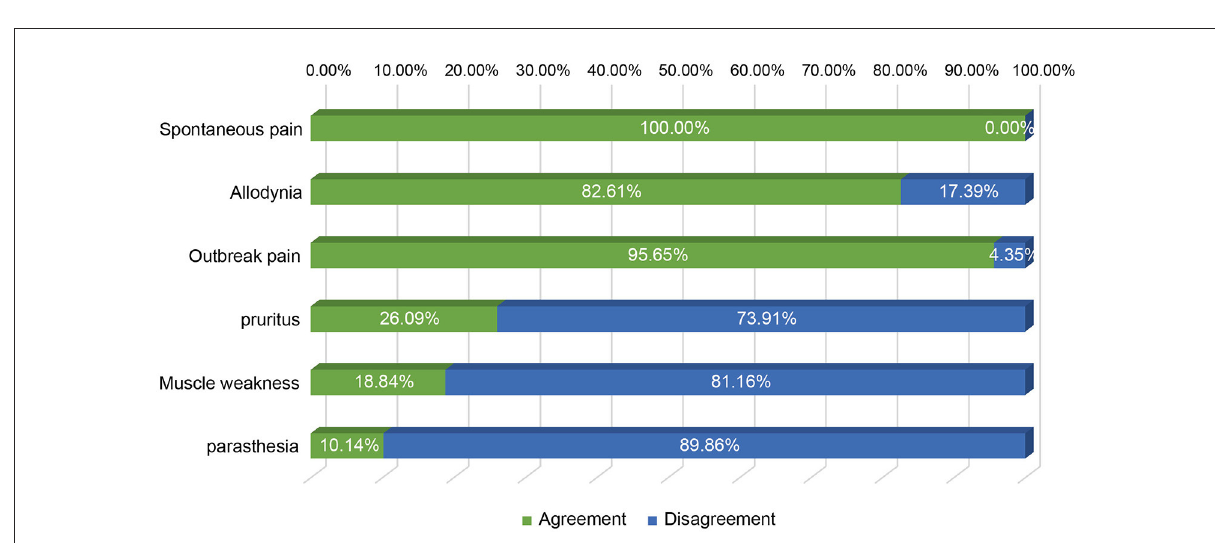
FIGURE3 Improvement of HN symptoms by st-SCS. All experts agreed that treatment with st-SCS provided relief from spontaneous pain (100%), outbreak pain (95.65%), and allodynia (82.61%). Conversely, the more common disagreements were that the symptoms of paresthesia (89.86%), muscle weakness (81.16%), and pruritus (73.91%) could be improved by